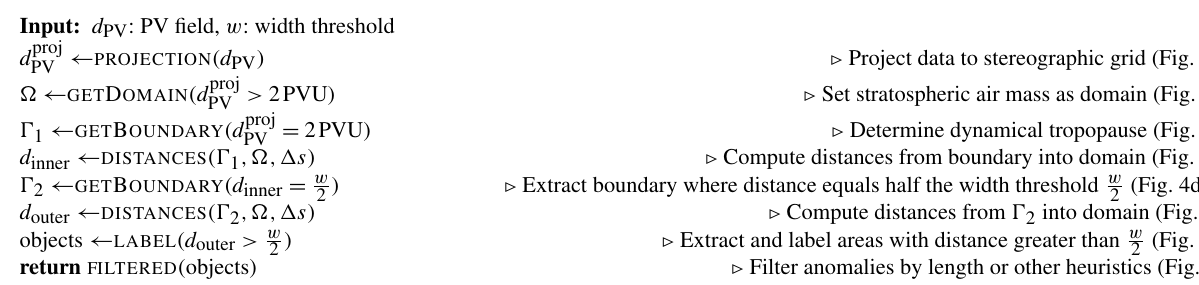
Algorithm 1 Pseudo-code of the identification process, both for 2-D and 3-D application. The 2-D and 3-D identifications differ with respect to distance measure (scale analysis for 3-D) and filtering strategy (additional area-based filtering for 3-D); cf. Sect.